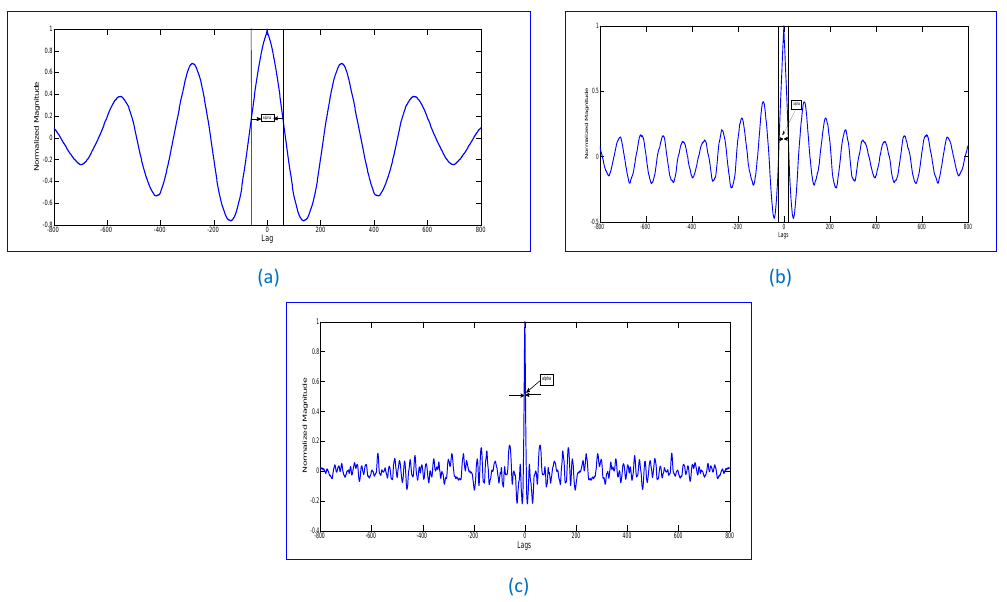
Figure 6. Auto-correlation signal of an object when it is: ( a ) stationary; ( b ) starts moving; and ( c ) movement detected.